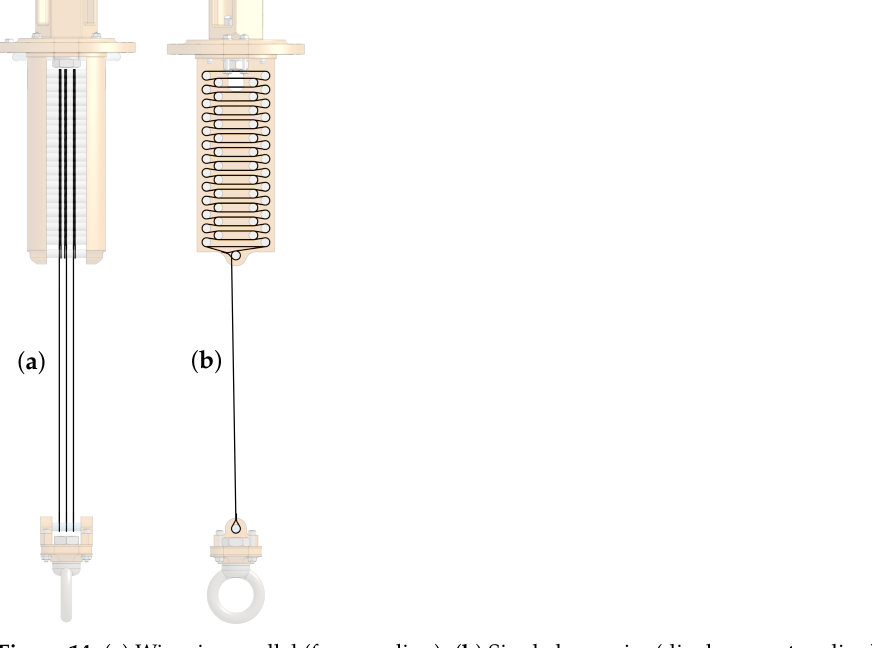
Figure 14. ( a ) Wires in parallel (force scaling). ( b ) Single long wire (displacement scaling).